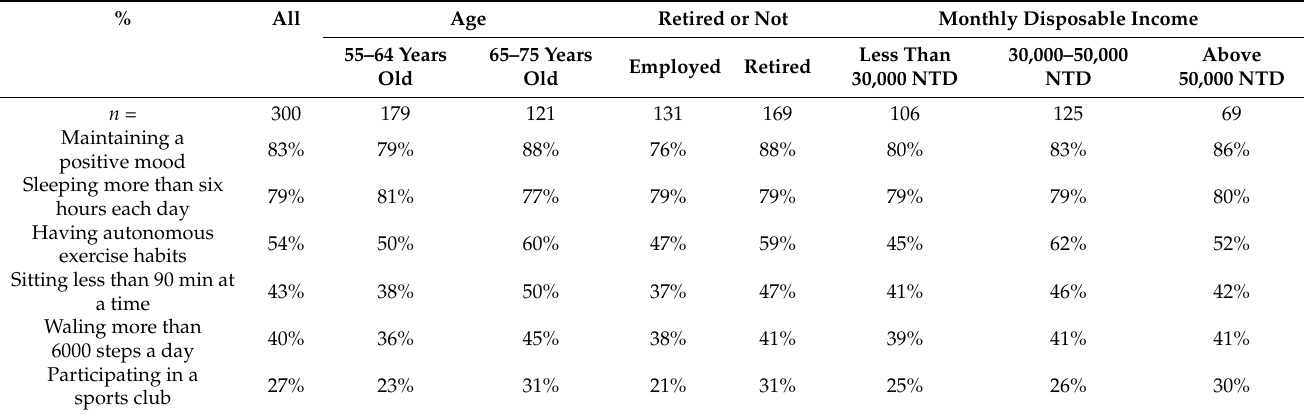
Table 3. Physical activities previously done by those aged 55–75 years.